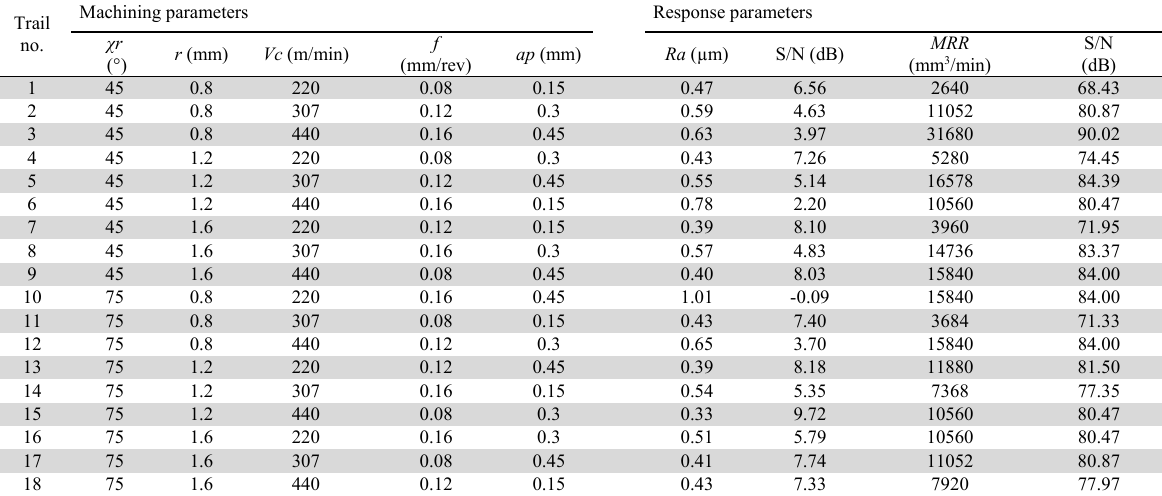
Experimental results for surface roughness and material removal rate with their computed S/N ratios Machining parameters Response Trail no.